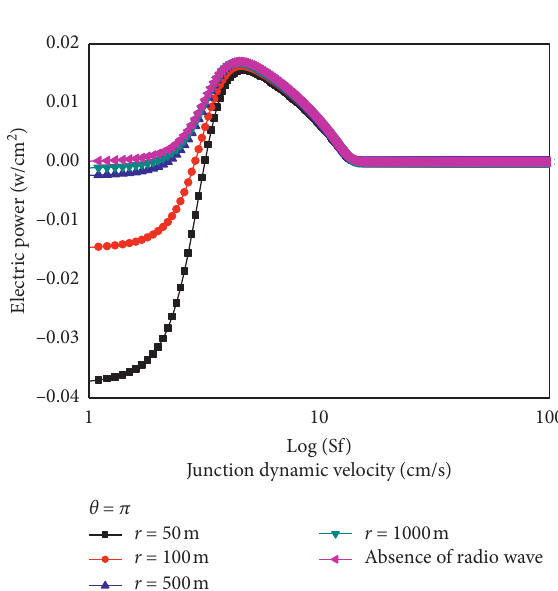
Figure 3: Power output as function of junction dynamic velocity for various